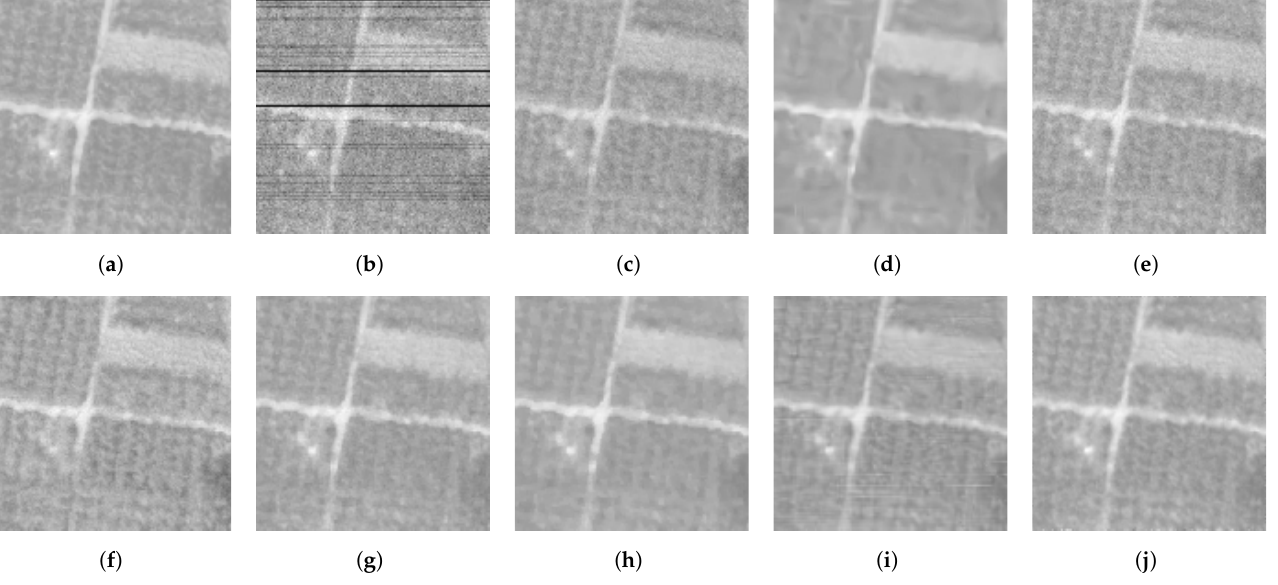
Figure 10. Case 5_2: The comparison of HSIs denoising results with existing methods on the Xiongan New Area dataset: ( a ) ground truth of band 15; ( b ) noisy image; ( c ) NNM; ( d ) BM4D; ( e ) WNNM;